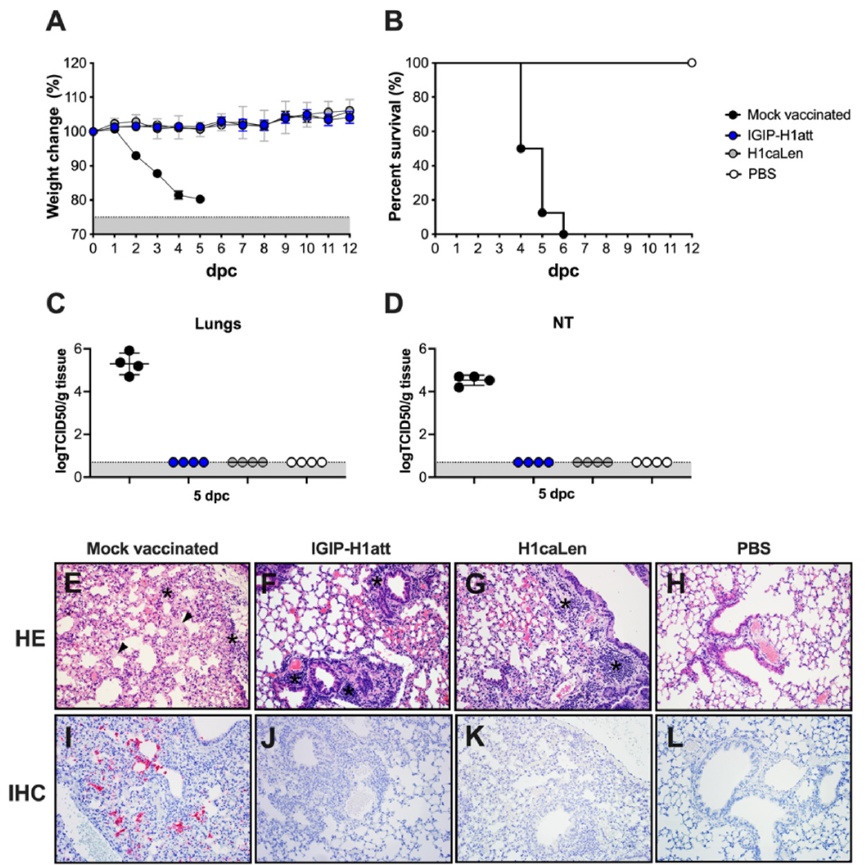
Figure 3 . Efficacy of IGIP-H1att against H1N1 lethal challenge in DBA/2 J mice. Mice ( n = 12/group) previously mock-vaccinated were mock challenged (white circles) or challenged (black circles) with 1 × 10 6 TCID50/mouse of Ca/04 (H1N1). Mice previously vaccinated with IGIP-H1att (blue circles) or H1caLen (grey circles) were challenged similarly. ( A ) Weight changes (Grey area represents mice reaching humane endpoints) and ( B ) Survival were monitored for 12 days. At 5 dpc, mice ( n = 4/group) were humanely euthanized, and the viral load was evaluated in tissue samples from ( C ) lungs and ( D ) nasal turbinates. Gray area corresponds to levels below detection for the assay ( E–H ) Histopathological examination from lungs collected at 5 dpc from each group. ( E ) Mock-vaccinated group : Multifocally the alveolar septa are necrotic, collapsed, ruptured and thickened by hyaline membranes (arrowhead). Small to moderate numbers of macrophages, neutrophils, and lesser lymphocytes and plasma cells are infiltrating perivascular and peribronchial spaces, alveolar septa, and pleura (asterisks). ( F ) IGIP-H1att- and ( G ) H1caLen-vaccinated groups: Small multifocal clusters of lymphocytes and plasma cells are infiltrating peribronchial and perivascular spaces (asterisks). ( H ) Normal lung. ( I–L ) Immunohistochemistry against IAV antigens in lungs collected at 5 dpc. ( H ) Mock-vaccinated group: Moderate amount of IAV antigens is present as evidenced by the red staining. ( J ) IGIP-H1att, ( K ) H1caLen and ( L ) PBS groups. All representative pictures were taken at 20 ×